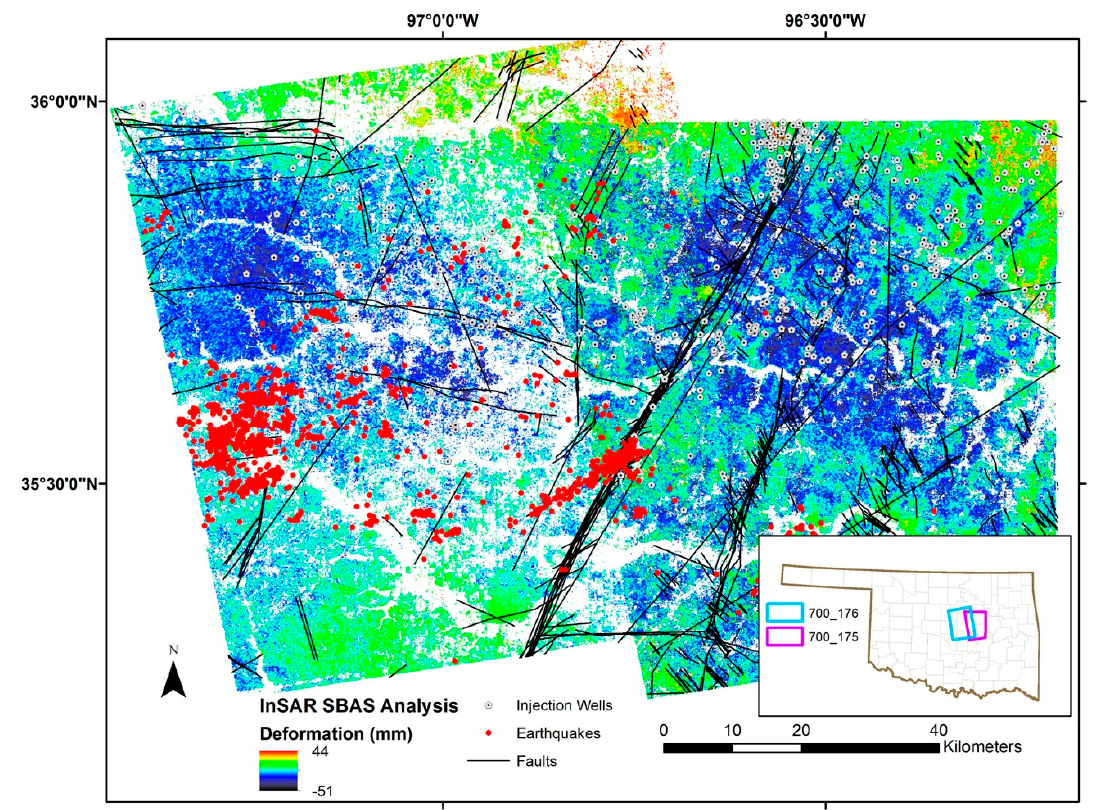
Figure 4. Regional Deformation and auxiliary Shapefiles of 2.9 M w or larger earthquakes for InSAR analysis time frame, faults, and 2011 injection well inventory. Insert shows location of processed InSAR frames. All deformation is measured in Line of Sight (LOS). Negative values represent movement away from the satellite, whereas positive values indicate movement towards the satellite.